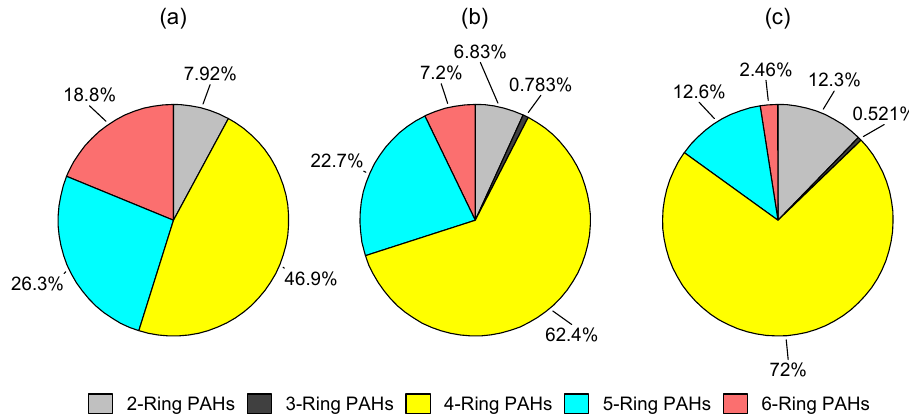
Figure 5. Distribution of PAHs emissions according to the number of aromatic rings: ( a ) WL; ( b ) FL; ( c ) EX.